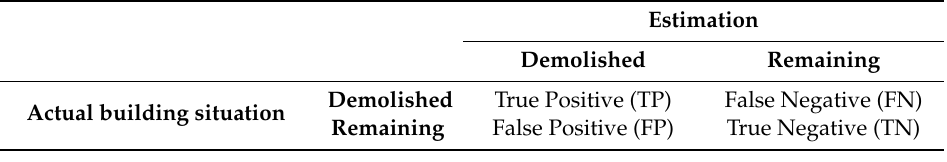
Table 3. Confusion matrix between estimated class and interpretation.